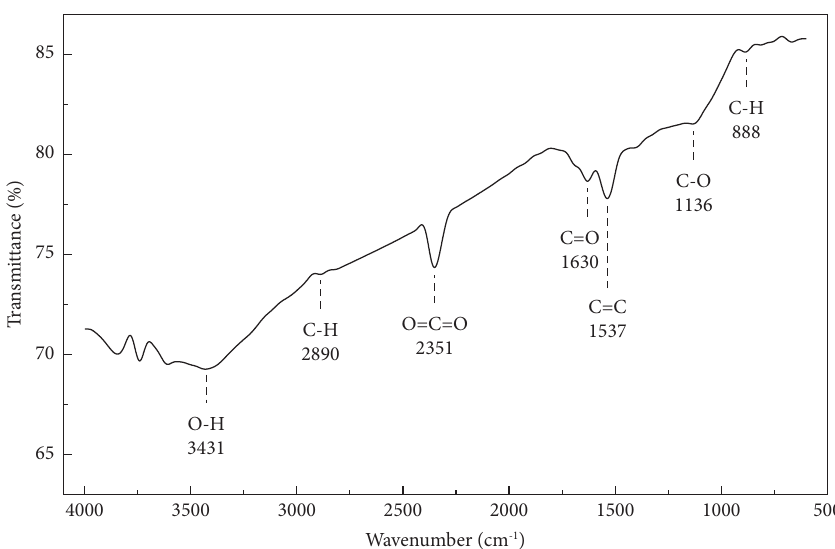
Figure 6: FTIR spectroscopy of